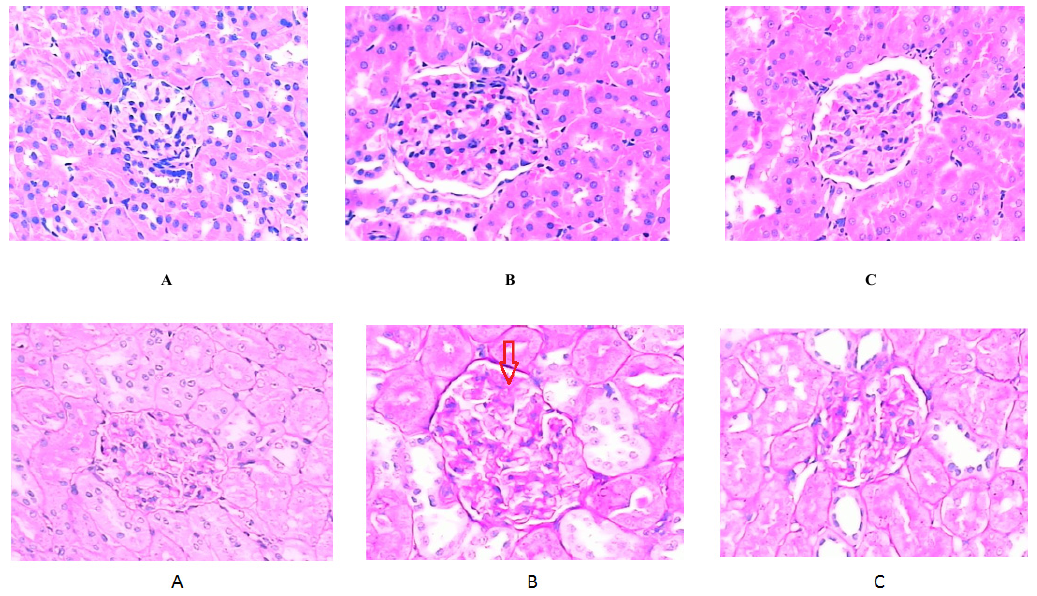
Figure 2. Histomorphologic changes verified by micro and ultraminiature observation of the kidneys: first line: hematoxylin and eosin (H&E) stain, ×800; second line: periodic acid-Schiff (PAS) stain, ×800; third line: Masson’s stain, ×800; Fourth line: electron microscopy; A. normal control group; B. diabetic control group; C. diabetic α -lipoic acid (ALA)-treated group. Glomerular hypertrophy, expansion of the mesangial region, mesangial cell proliferation, and some inflammatory cell infiltrate were also observed in H&E-stained sections under light microscopy. The expansion of the mesangial region, thickening and interruptions in the glomerular basement membrane (GBM) were